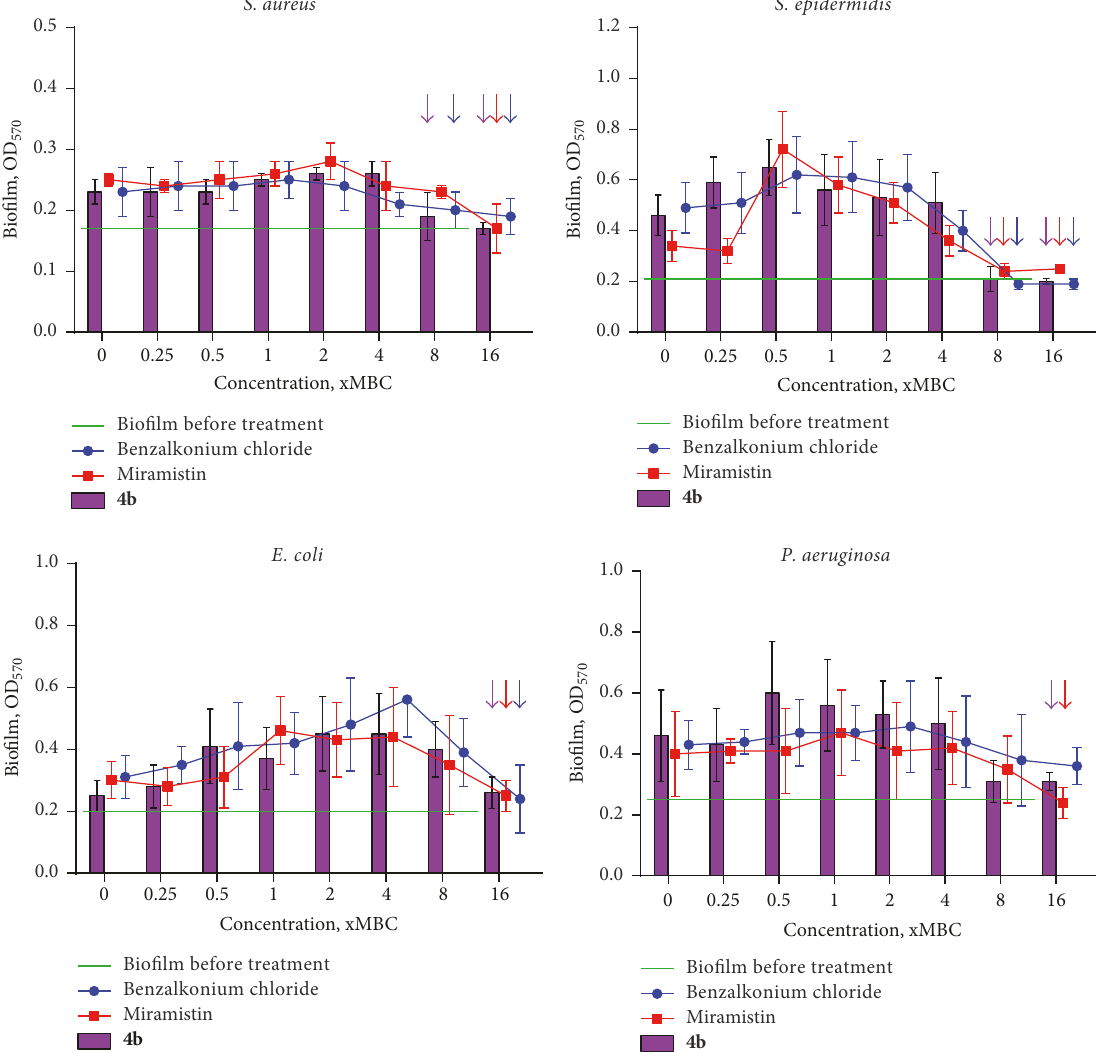
Figure 2: The effect of 4b , miramistin, and benzalkonium chloride on bacterial biofilm formation. The 24-h biofilms (green line) were treated with 0.25–16 × MBCs of antimicrobials or 4b (bars) for 24 h and then were quantified with crystal violet assay. Data are present as averages from five independent experiments with standard deviations. Arrows indicate no differences with the initial biofilm